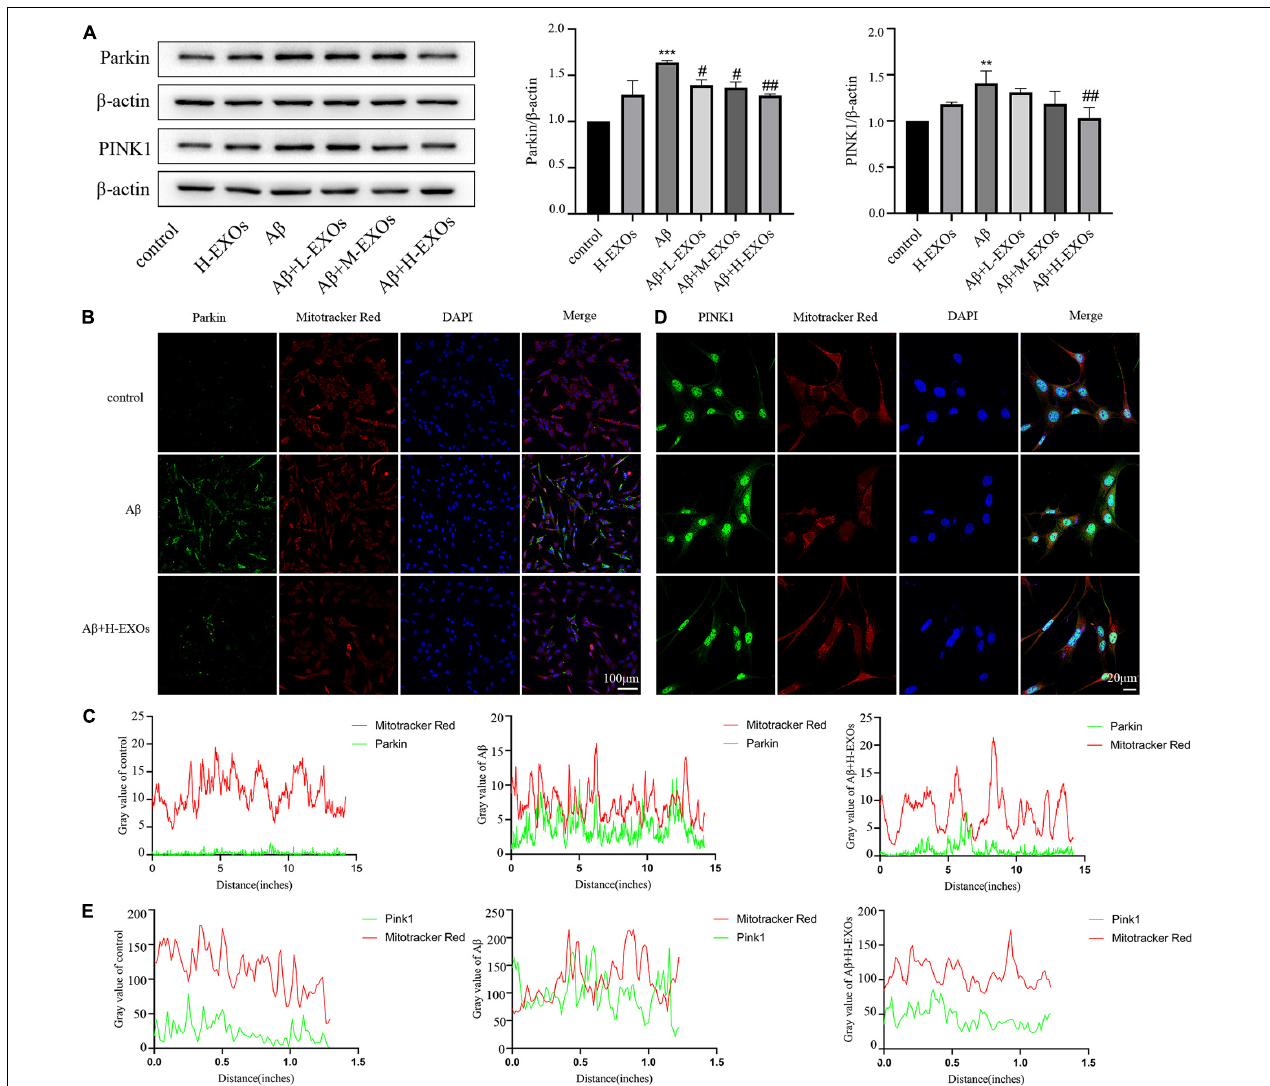
FIGURE 6 | PINK1/Parkin-mediated mitophagy is associated with the protective effects of M2-EXOs. (A) Immunoblot images and quantitative analysis of Parkin and PINK1 in the AD model with or without M2-EXO incubation. (B) Representative images of Parkin determined by immunofluorescence. (C) Colocalization of immunofluorescence signals between Parkin and MitoTracker. (D) Representative images of PINK1 determined by immunofluorescence. (E) Colocalization of immunofluorescence signals between PINK1 and MitoTracker. All experiments were repeated three times. ** P < 0.01 vs. control, *** P < 0.001 vs. control, # P < 0.05 vs. A β , ## P < 0.01 vs. A β